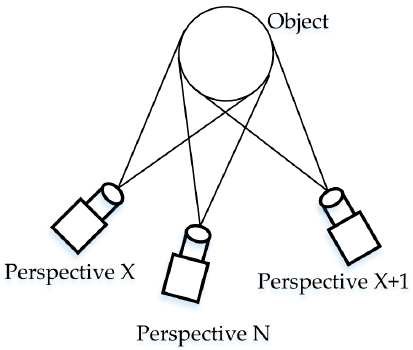
Figure 9. Relationship between various perspectives.